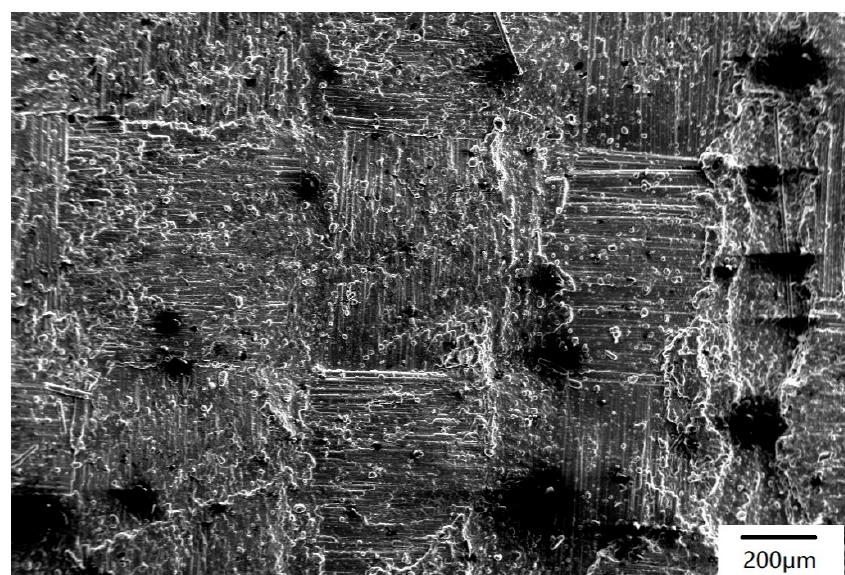
Figure 2. Surface morphology of the C/SiC composite.